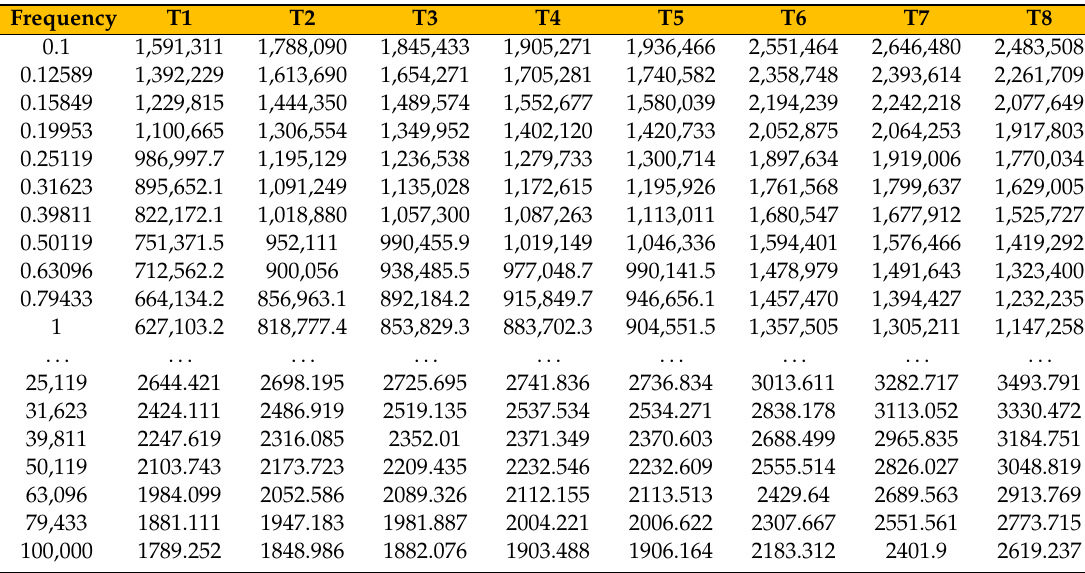
Table 6. A sample of impedance measurement in 8 di ff erent times, in the range of 0.1–100 KHz, when the concentration of SPIONs is C1.